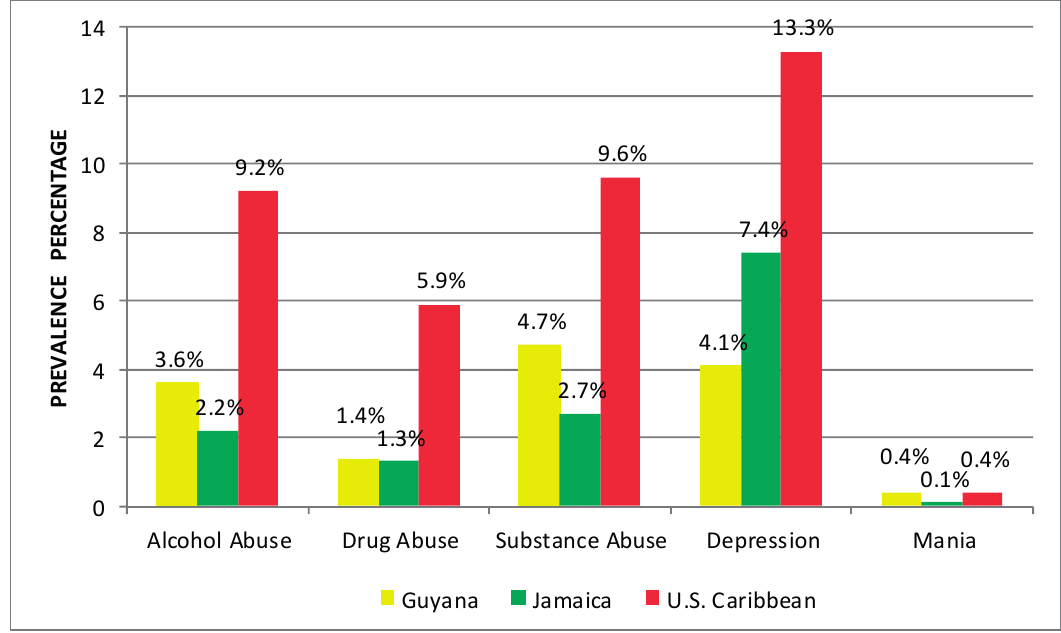
Figure 1. Lifetime prevalence of substance use and mental disorders by country.